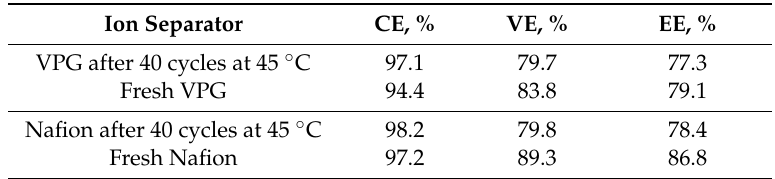
Figure 18. Charge-discharge curves at 40 mA/cm 2 and 25 °C for VRFBs before and after the 40-cycle Figure 18. Charge–discharge curves at 40 mA/cm 2 and 25 ◦ C for VRFBs before and after the 40-cycle operations at 45 °C: ( a ) VPG-VRFB and ( b ) Nafion-VRFB. operations at 45 ◦ C: ( a ) VPG-VRFB and ( b ) Nafion-VRFB. Table 3. Charge–discharge efficiencies measured at 25 ◦ C under a current density of 40 mA/cm 2 for Table 3. Charge-discharge efficiencies measured at 25 °C under a current density of 40 mA/cm 2 for the VRFBs before and after operating at 45 ◦ the VRFBs before and after operating at 45 °C.